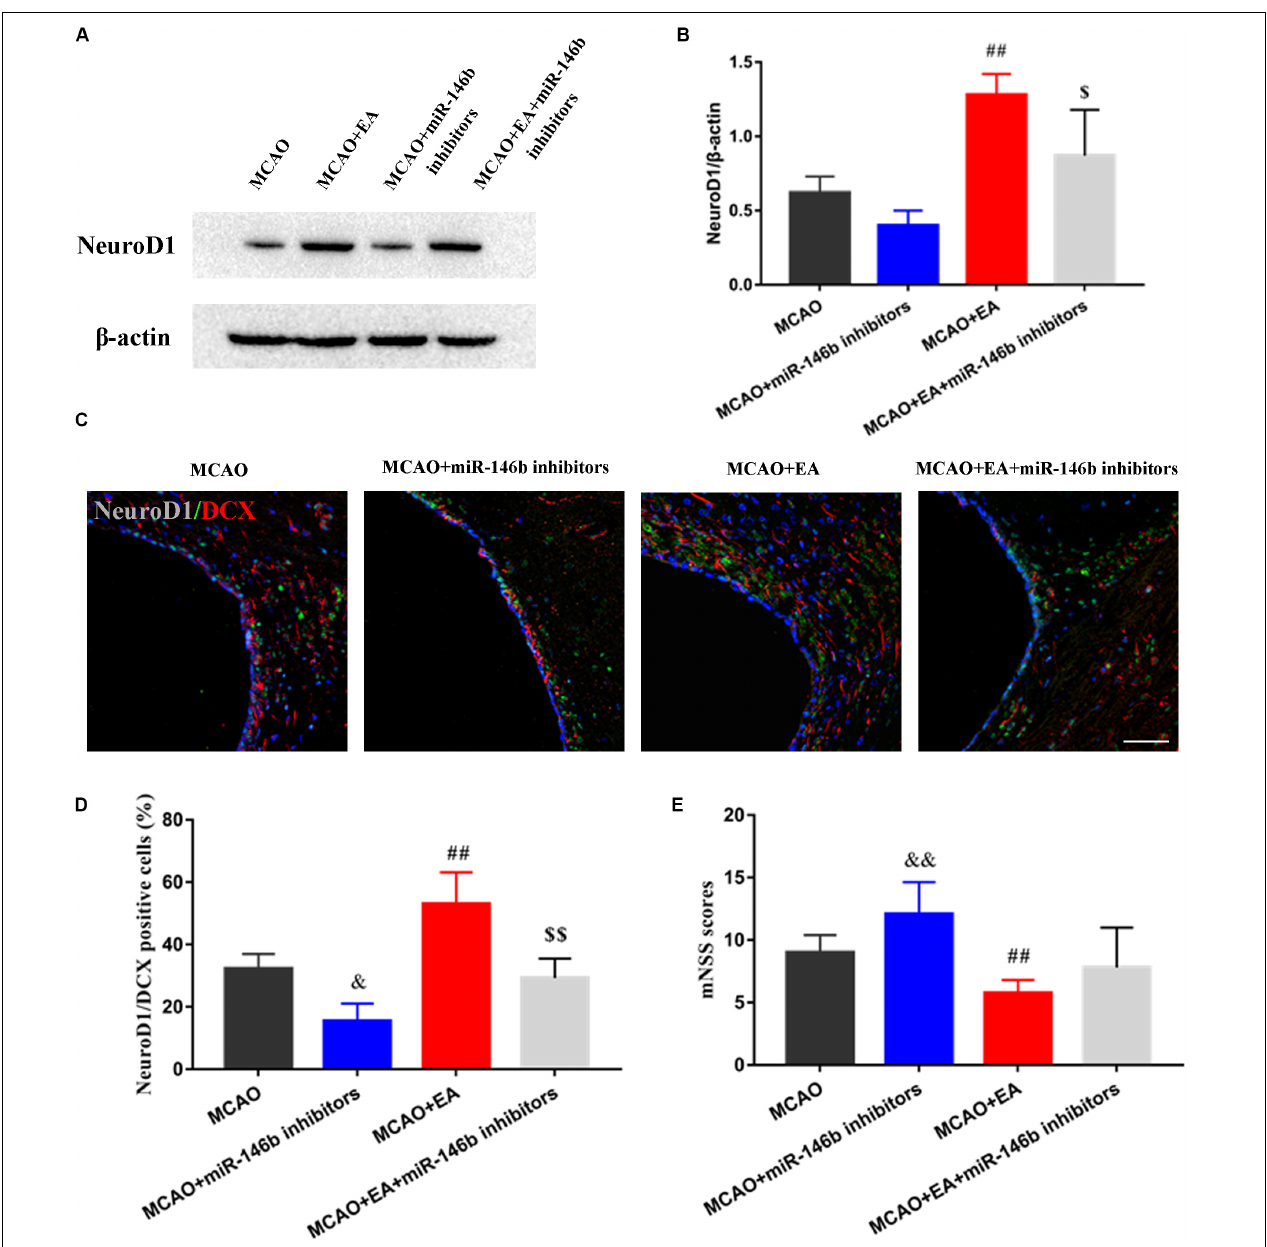
FIGURE 4 | Electro-acupuncture promotes NeuroD1 associated neuron differentiation in SVZ of ischemic hemisphere. (A) The expression of NeuroD1 of neuronal differentiation-associated marker was analyzed by Western blotting in SVZ of ischemic hemisphere. (B) The expression of markers were quantified on the basis of average band intensity ( n = 3). (C) Immunofluorescence and co-localization of NeuroD1 with DCX in SVZ of ischemic hemisphere. (D) Co-localization of NeuroD1 with DCX positive cells ( n = 3). (E) The mNSS scores were tested in MCAO, MCAO+miR-146b inhibitors, MCAO+EA, MCAO+EA+miR-146b inhibitors groups ( n = 10). Data represent means ± SD of the results of representative experiment. ## P < 0.01, MCAO vs. MCAO+EA; & P < 0.05 and && P < 0.05, MCAO vs. MCAO+miR-146b inhibitors; $ P < 0.05 and $$ P < 0.05, MCAO+EA vs. MCAO+EA+miR-146b